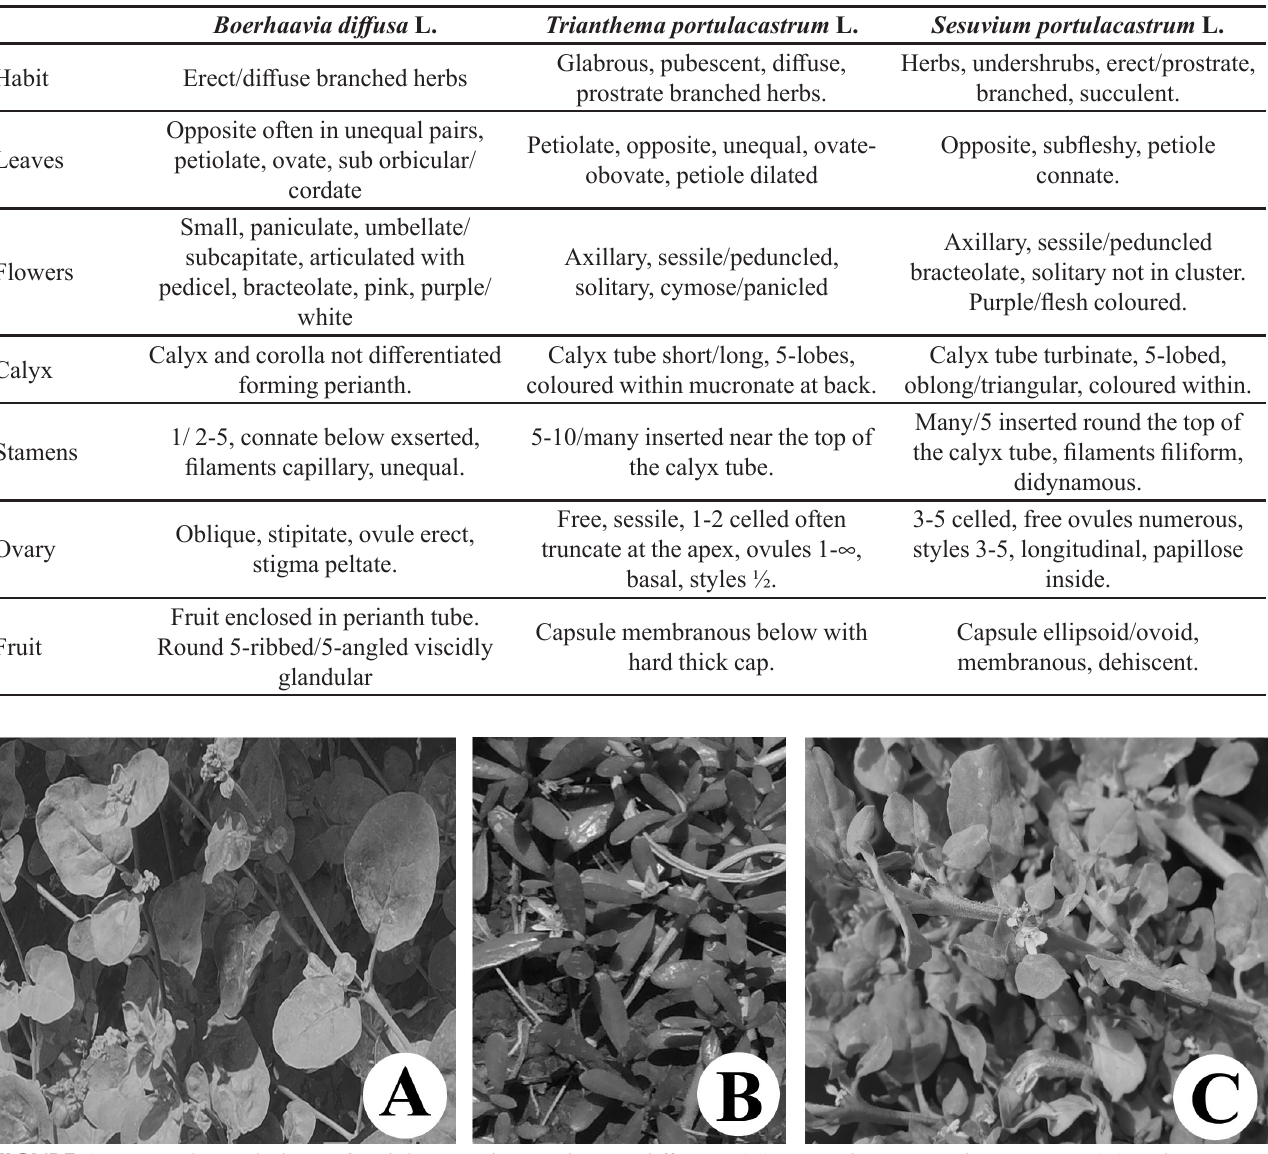
FIGURE 1 - General morphology of aerial organs in Boerhaavia diffusa L. (A), Trianthema portulacastrum L. (B) and Sesuvium portulacastrum L. TABLE II - Micro-morphology of plants studied Micro-morphology